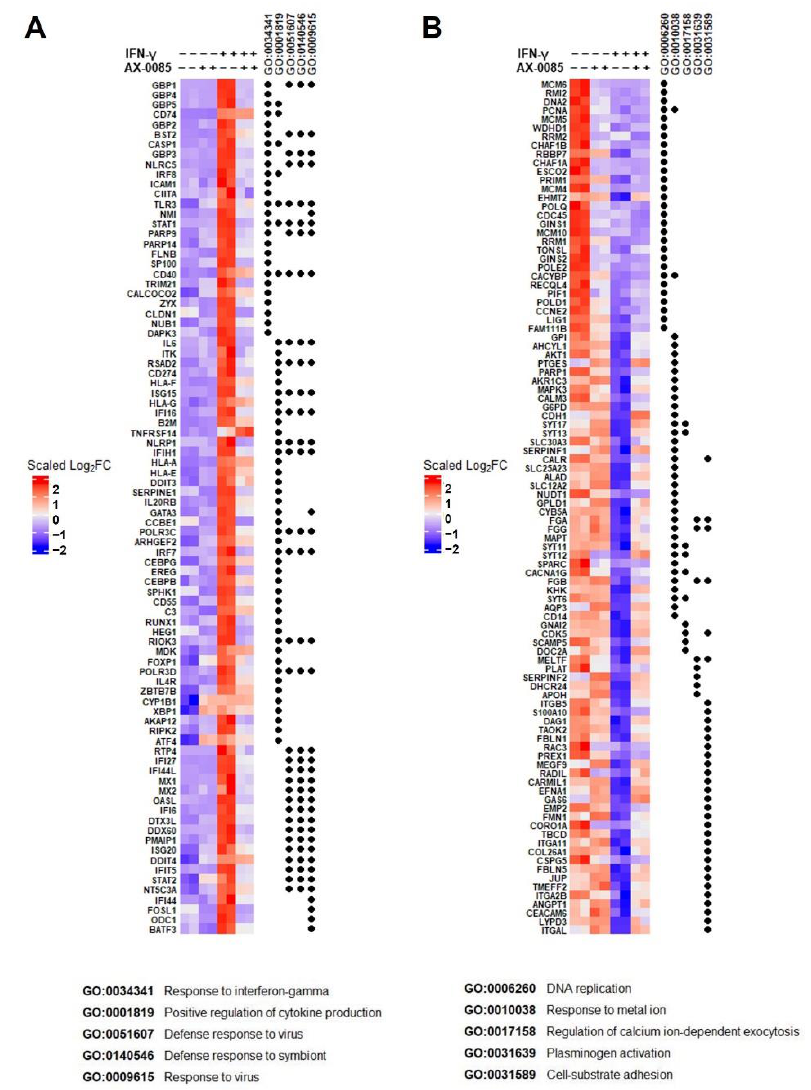
Figure 4. Transcriptomic analyses of IFN- γ signaling by AX-0085. Heat map representation of gene expression. Genes from the top 5 up-regulated ( A ) and down-regulated ( B ) GO term groups upon IFN- γ treatment are shown on the left in duplicates. The changes in their expression upon further treatment with AX-0085 are shown on the right. For GO IDs specified above, the groupings are indicated by black dots and terms are listed at the bottom (also listed in Supplementary Files S2 and